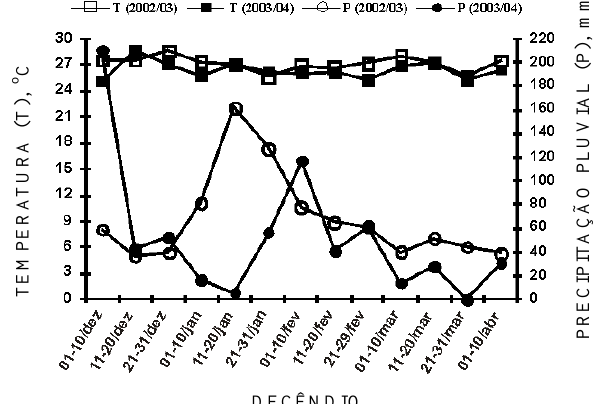
Figura 1. Precipitação pluvial (P) e temperatura média (T) ocorridas durante os experimentos, anos agrícolas 2002/03 e 2003/04.